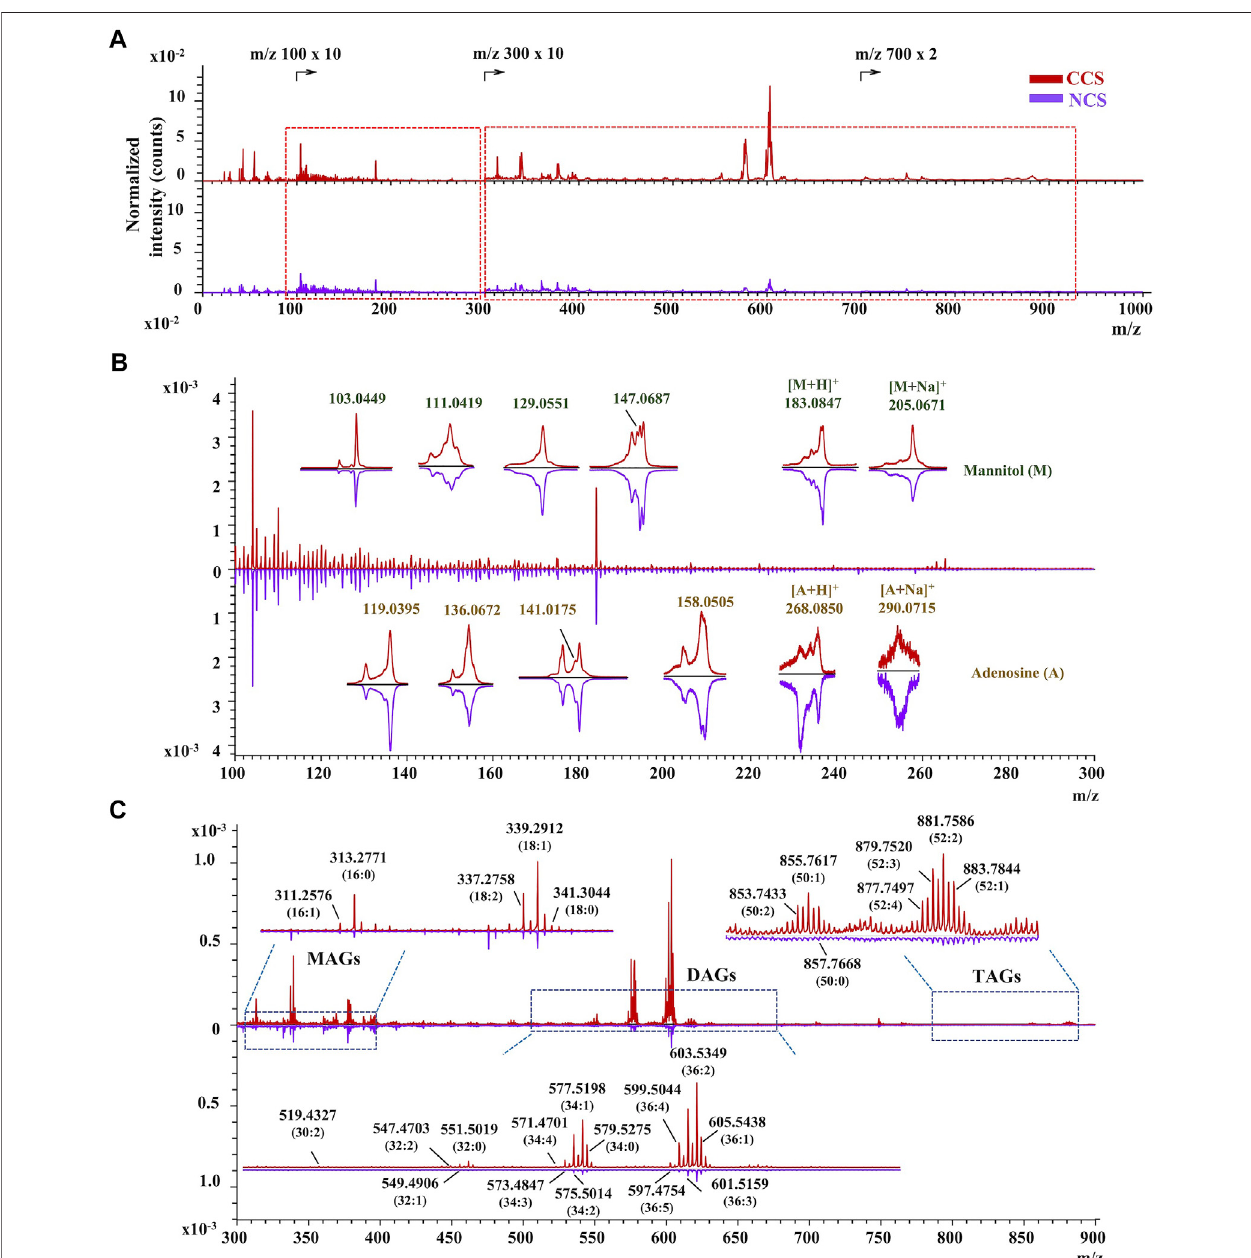
FIGURE 3 | The TOF-SIMS spectra of CCS and NCS samples in positive mode. (A) The typical spectra of CCS (No. 6 in red) and NCS (No. 13 in purple) samples. (B) Identi fi cation of mannitol and adenosine with both essential and characteristic fragment ions in the magni fi ed region with m/z value ranging from 100 to 300. (C) CharacterizationofrepresentativeMAGs,DAGsandTAGsintheenlargedregionwithm/zvaluefrom300to900.TheTOF-SIMSspectrawerenormalizedbyprimaryion dose (PID).